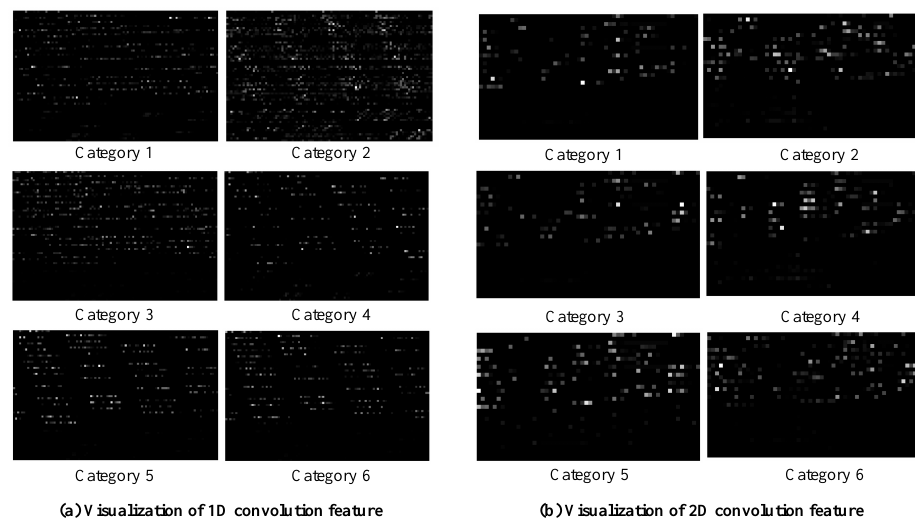
Figure 15. Visualization of 1D and 2D dimensional convolution feature